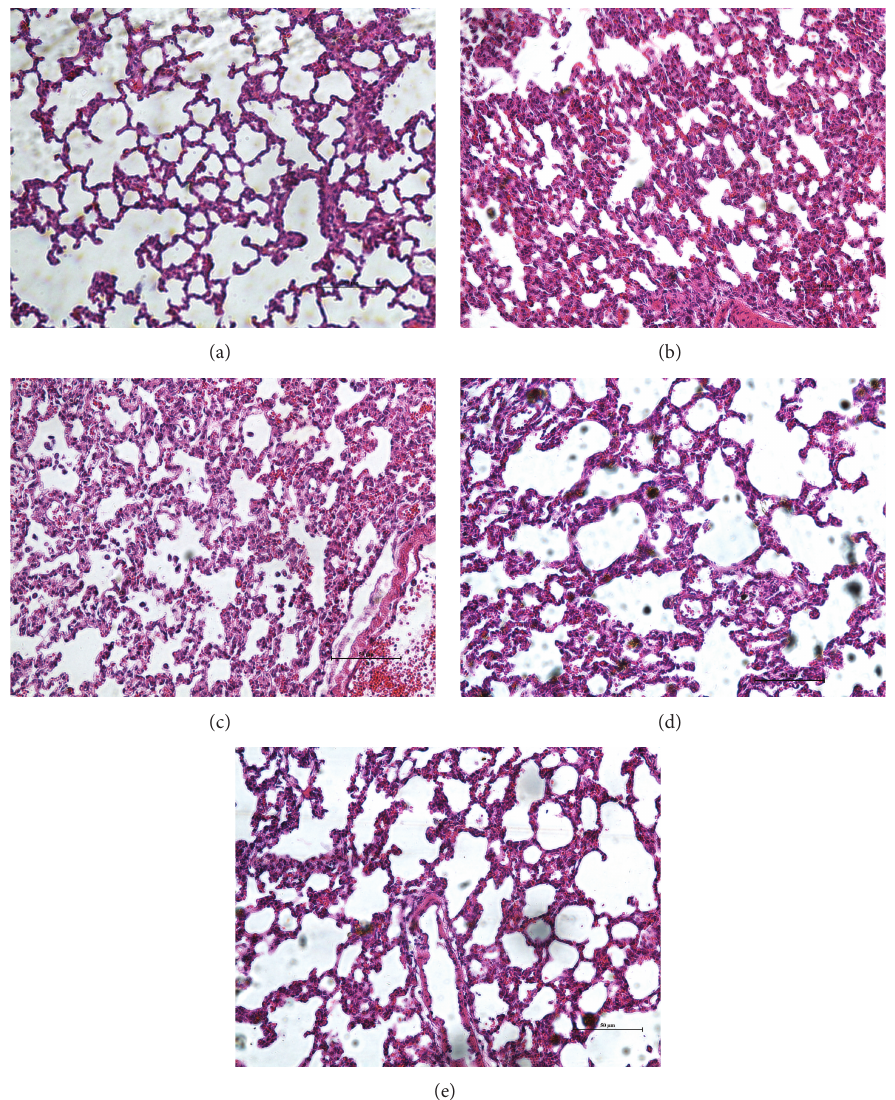
Figure 2: Microscopic findings of the lung tissues stained with hematoxylin and eosin. (a) Sham operation group. The lung tissues showed normal to minimal pulmonary inflammation. (b) CLP group. The lung tissues showed severe pulmonary inflammation. (c) Small dose (5 𝜇 g/kg) group. The lung tissues showed severe pulmonary inflammation. (d) Medium dose (10 𝜇 g/kg) group. The lung tissues showed moderate pulmonary inflammation. (e) Large dose (20 𝜇 g/kg) group. The lung tissues showed mild pulmonary inflammation. (magnification